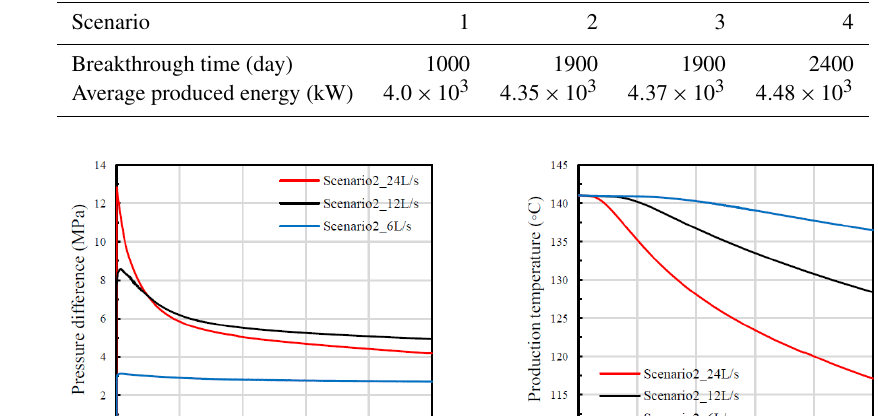
Table 3. Cumulative produced energy for 4 scenarios at 30th year.